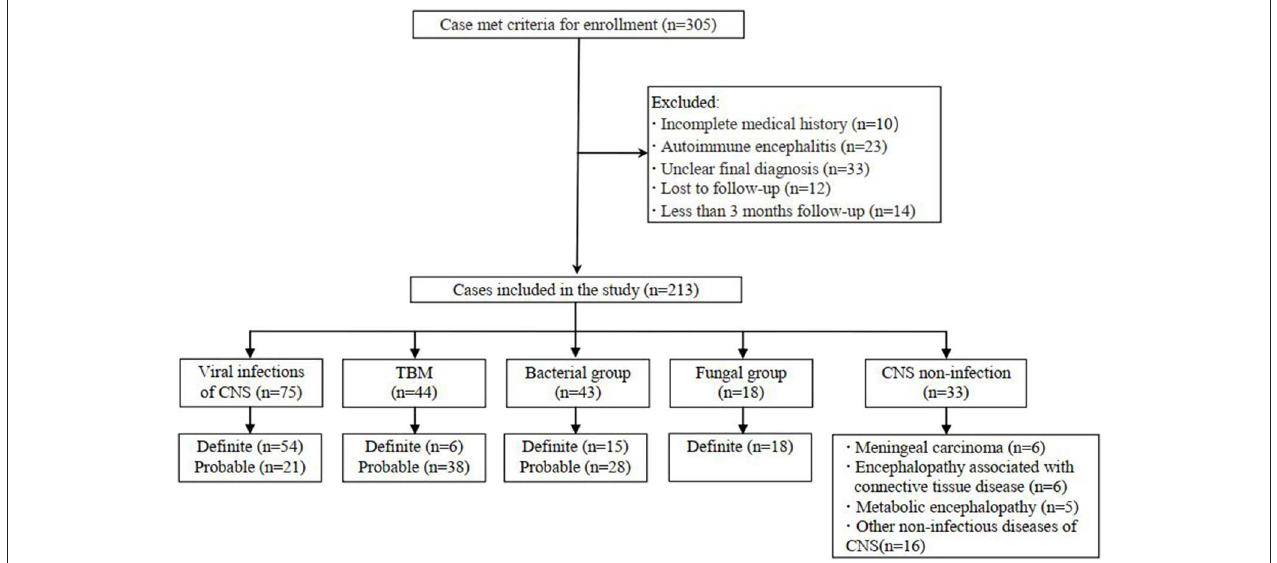
FIGURE 1 | Flowchart of study participants.